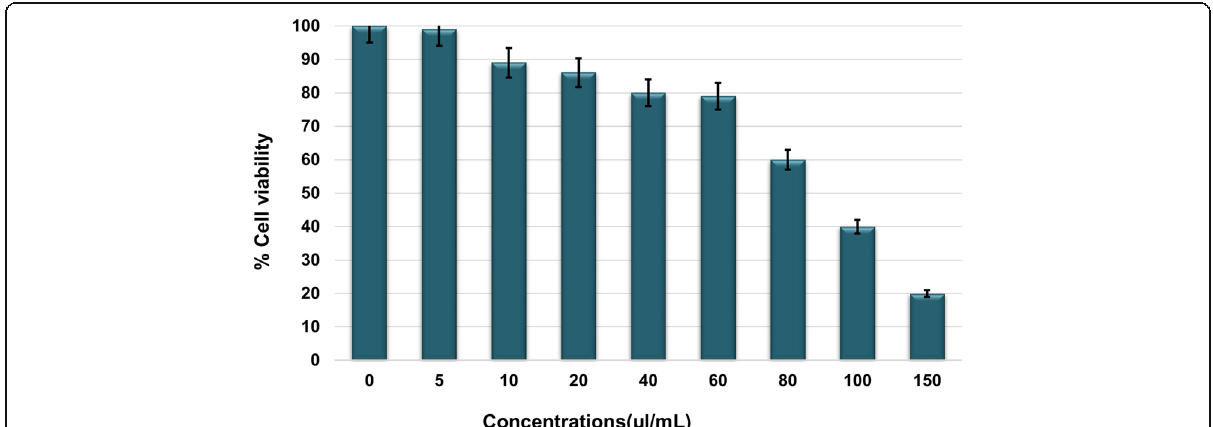
Fig. 1 Cell viability determination by MTT assay. Viability of HUVECs under the treatment of various concentrations of the crude microsystems.